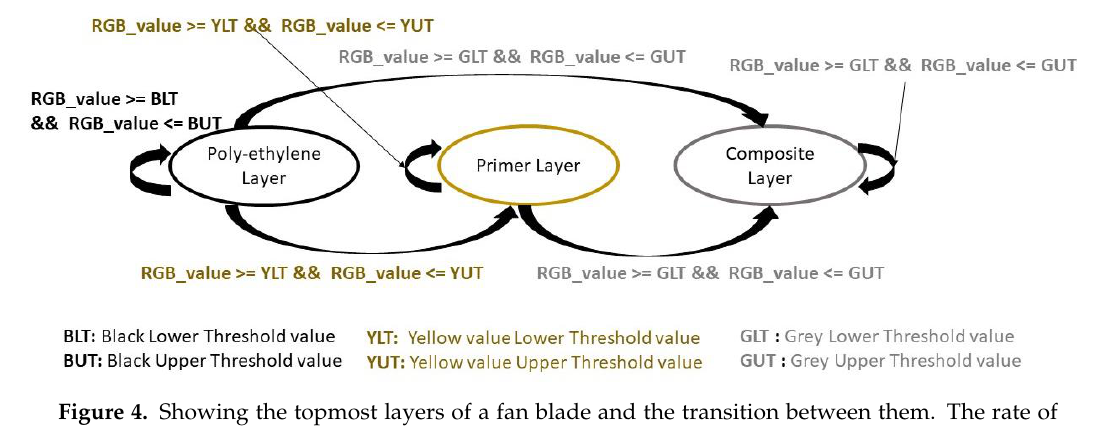
Figure 4. Showing the topmost layers of a fan blade and the transition between them. The rate of transition between the layers depend on the magnitude of the damage done to the fan blade, the time in service of the fan blade or the amount of grinding given to each